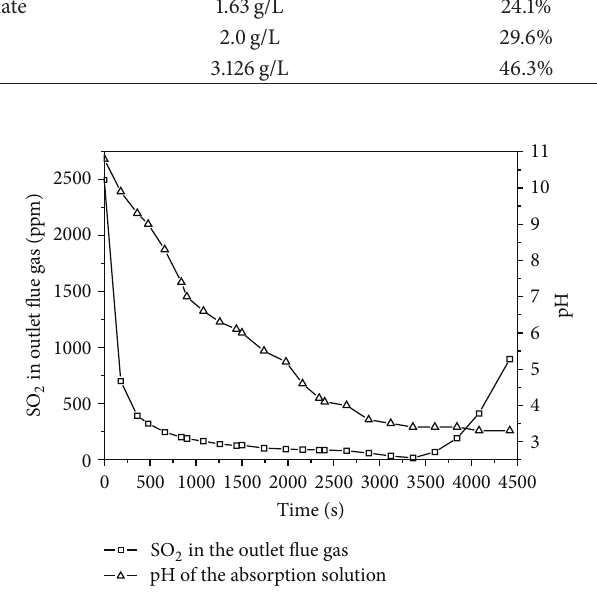
Figure 2: The profile absorption process of SO 2 in absorption solution. (SO 2 , 2500 ppm; gas flow, 0.12 m 3 /h; absorption solution 100mL; O 2 , 5vol%; 298